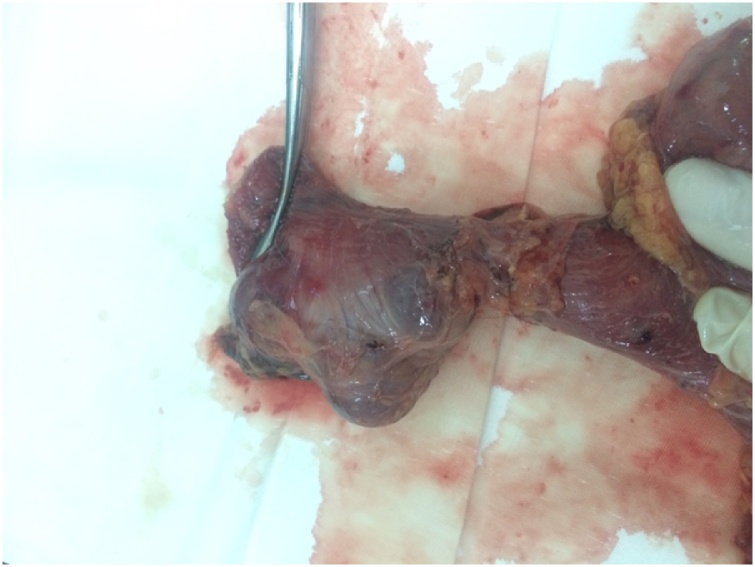
Surgical specimen.